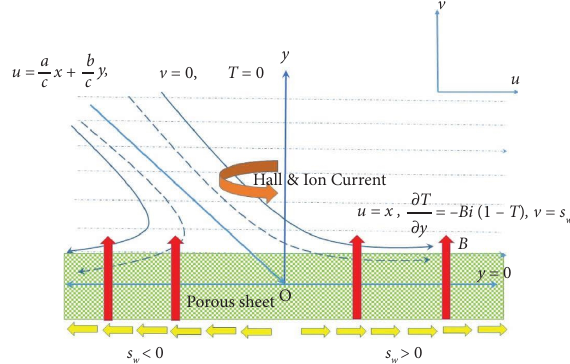
Figure 1: Geometrical description of the governed fuid